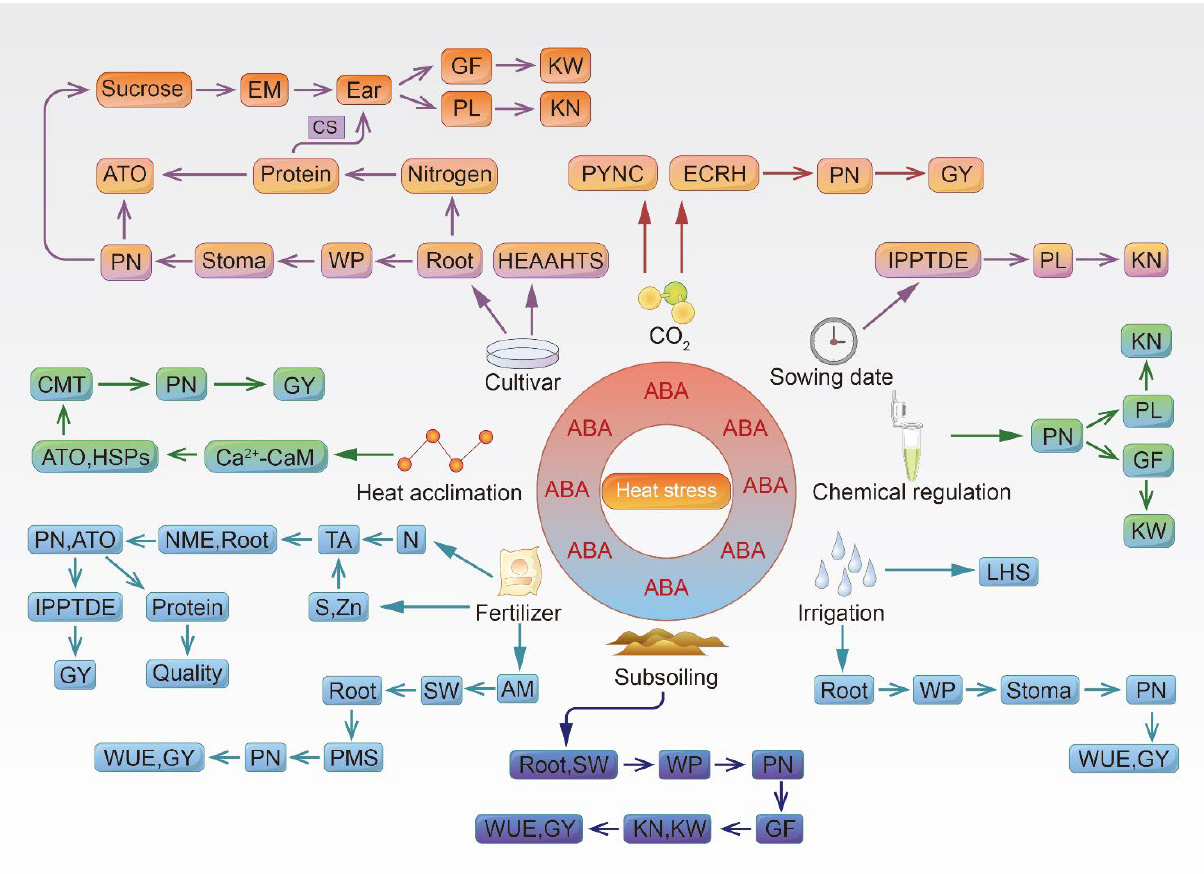
Figure 3. Diagram of how cultivation and farming techniques facilitate the adaptation of wheat and maize to high-temperature stress. AM, arbuscular mycorrhizal fungi; ATO, antioxidant ability; CMT, cell-membrane thermostability; CS, compensation for the loss of starch; ECRH, equilibrium of cell redox homeostasis; EM, energy and matter; GF, grain filling; GS, glutamine synthetase; GY, grain yield; HEAAHTS, heading early to avoid or adapt to high-temperature stress; IPPTDE, improve the production of photosynthates and promote transfer and distribution to ears; KN, kernel number per ear; KW, kernel weight; LHS, lower heat sensitivity; NME, nitrogen metabolism enzyme; PL, pollination; PMS, plant moisture status; PN, photosynthesis; PYNC, protein yield negatively correlated with CO 2 concentration; SW, soil water-holding capacity; TA, topdressing before and after anthesis; WP, water status of the plant; WUE, water use